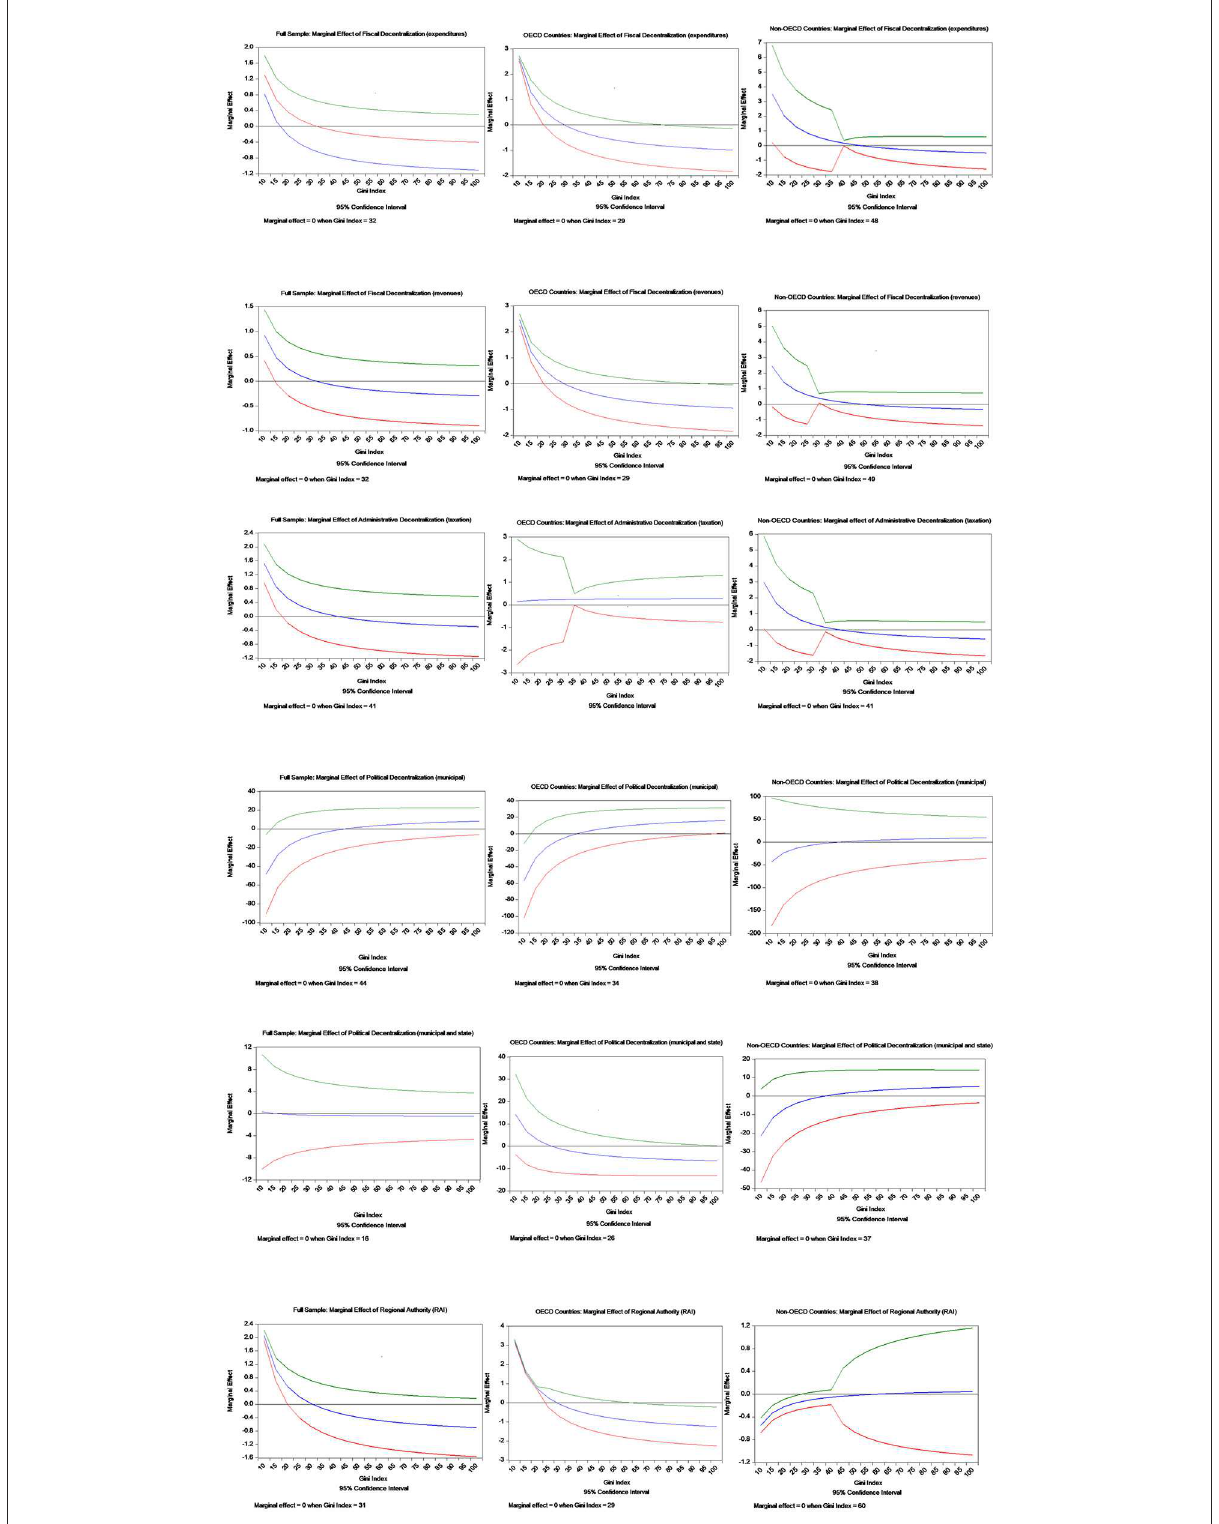
FIGURE1 Marginal effect of decentralization (contingent on income inequality) on